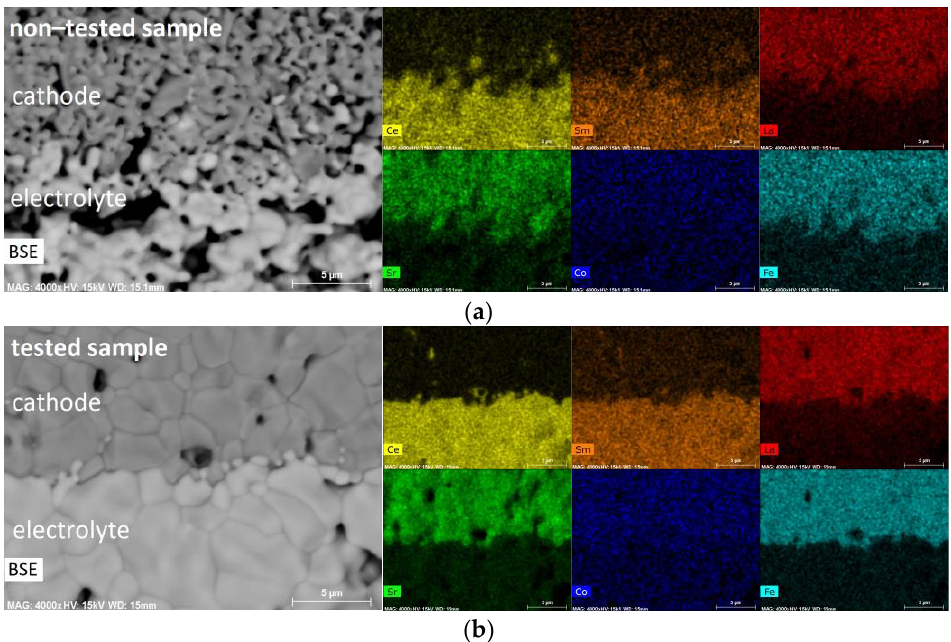
Figure 2. BSE-SEM surface micrograph and EDX mappings of the cathode–electrolyte interface ( a ) before and ( b ) after cell testing.